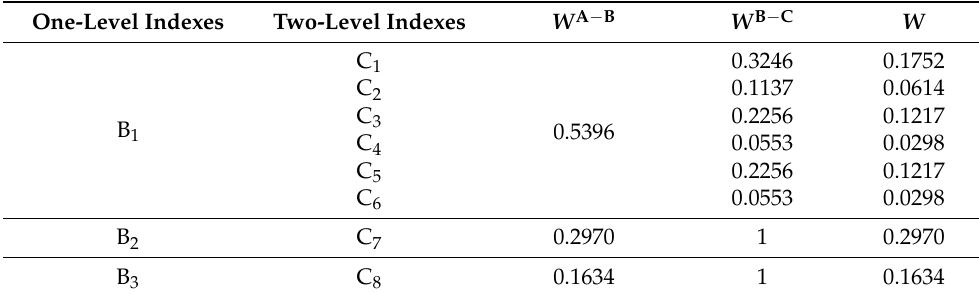
Table 4. Index weights of core fracture identification indexes.